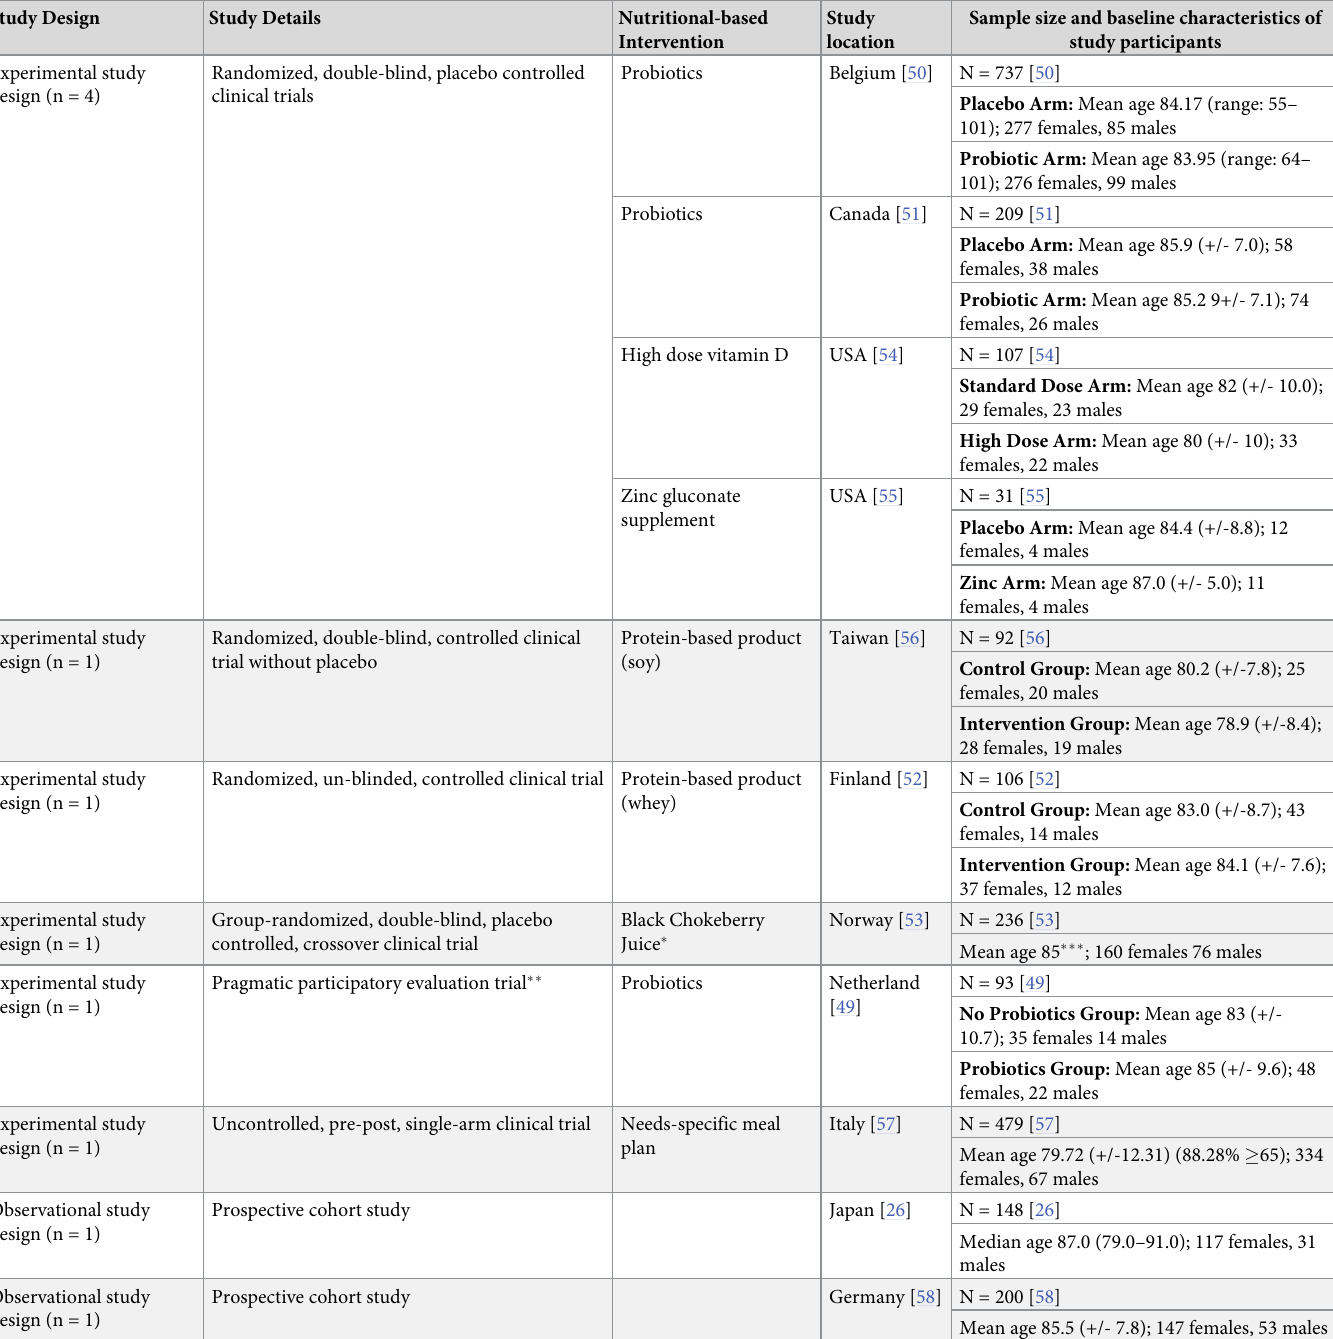
Table 1. Characteristics of included